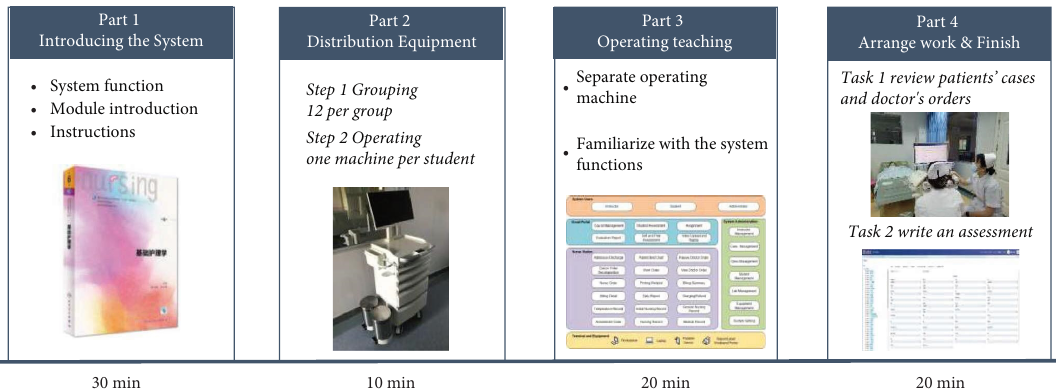
Figure 1: Te patient case writing team consists of 12 head nurses from diferent departments of the university’s afliated hospital and 12 teachers from the school of nursing. Cases are collected in the hospital, and patients’ private information is deleted and imported into the system. By the end of 2020, 10 cases would have been